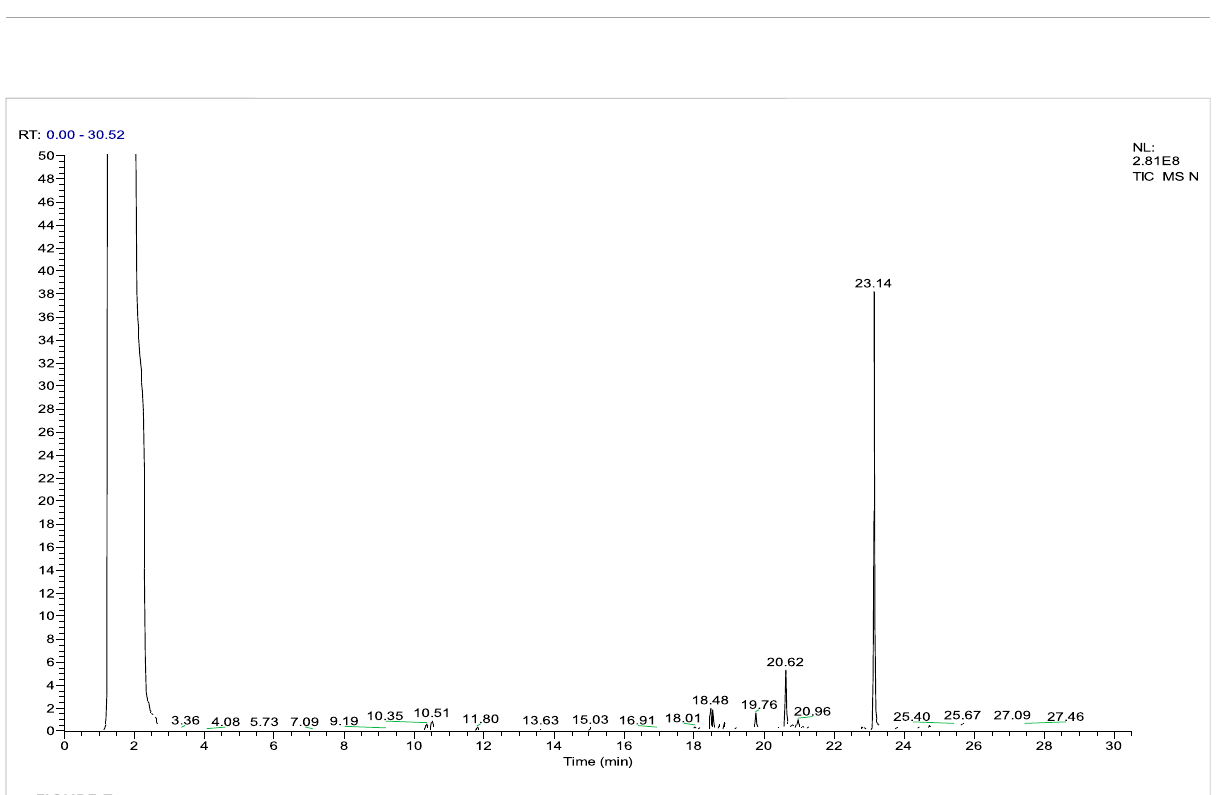
FIGURE 7 Chromatogram of the ethyl acetate fraction. Identi fi cation of phytochemical is based on peak area, molecular weight, and retention